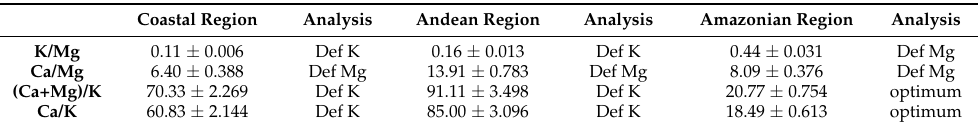
Table 3. The cationic relationships in soil between the three analyzed regions, optimum and deficiency